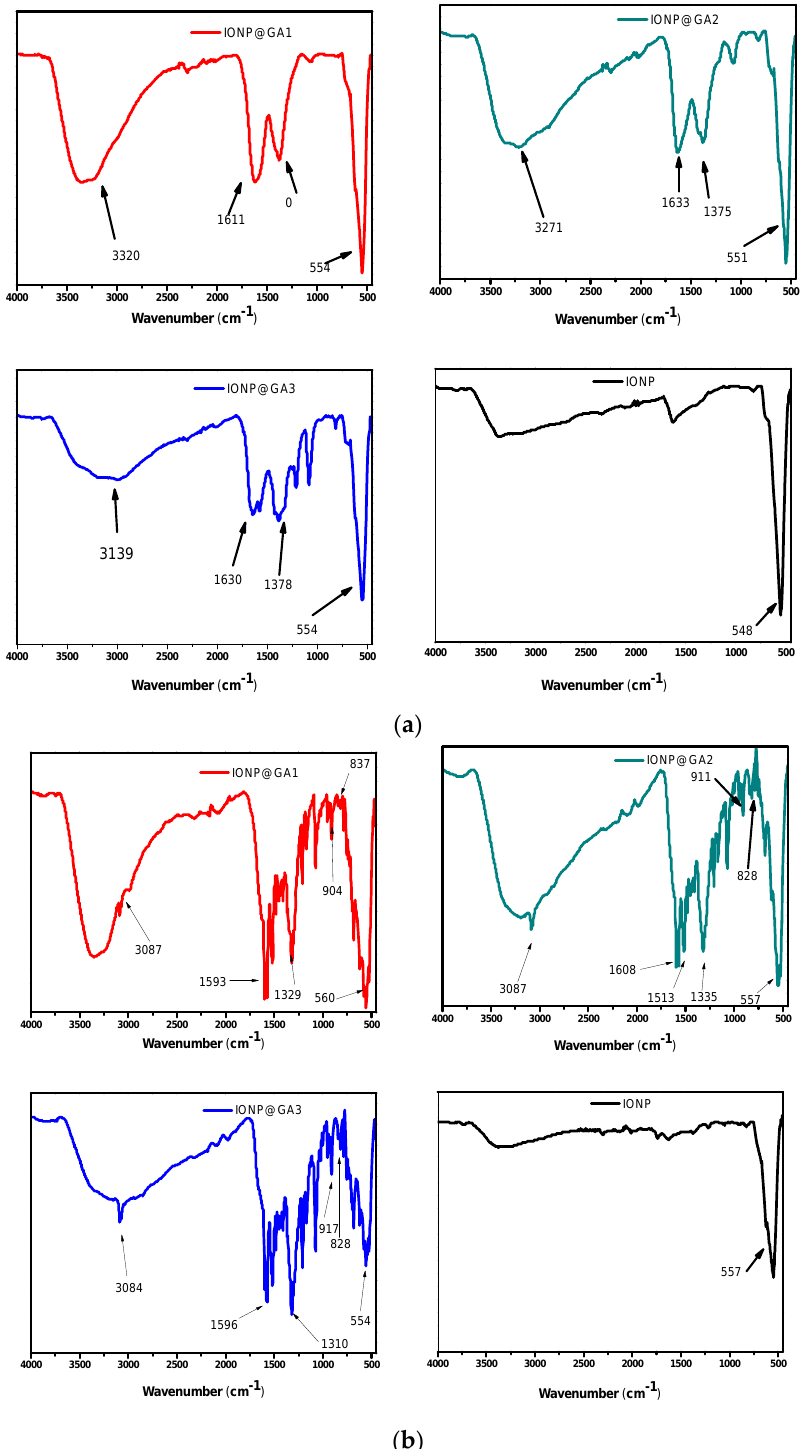
Figure 1. FTIR spectra of ( a ) IONP@GA before DPPH assay ( b ) IONP@GA after DPPH